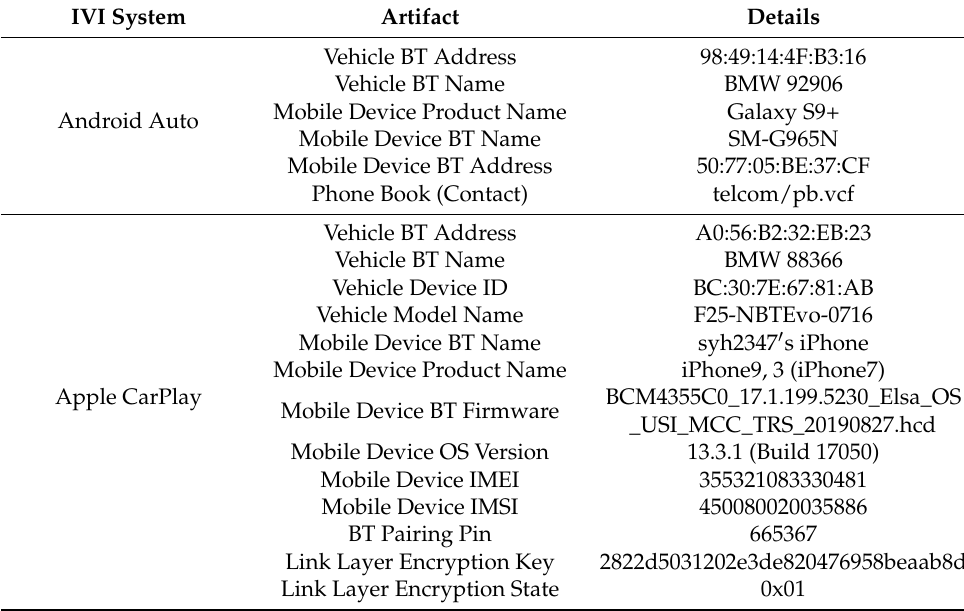
Table 4. List of Artifacts in Wireless Communication between the IVI and Mobile Device (Android Auto and Apple CarPlay).